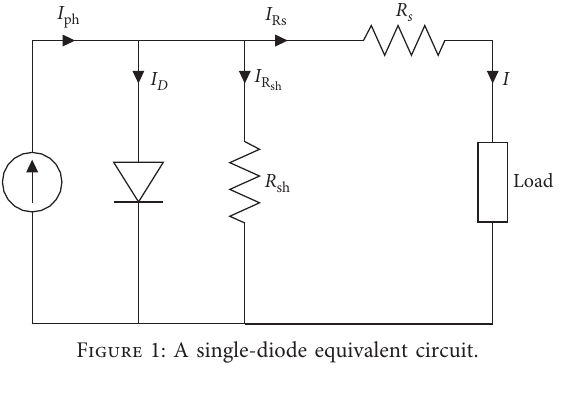
Figure 1: A single-diode equivalent